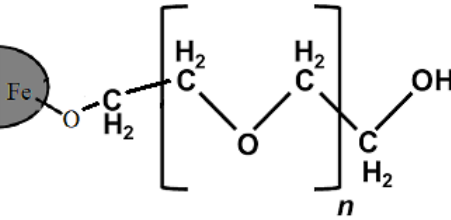
Figure 1. Stabilization of superparamagnetic iron oxide nanoparticles by polyethylene